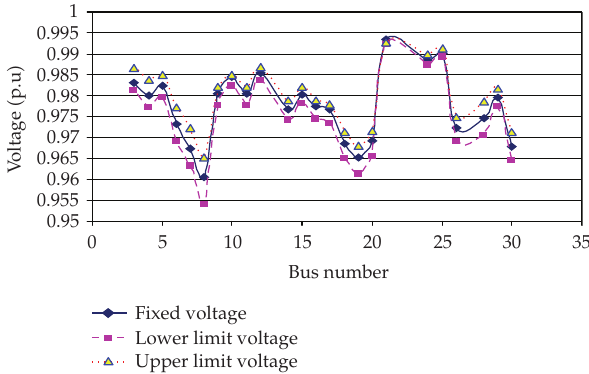
Figure 3: Voltage profile for load uncertainties.